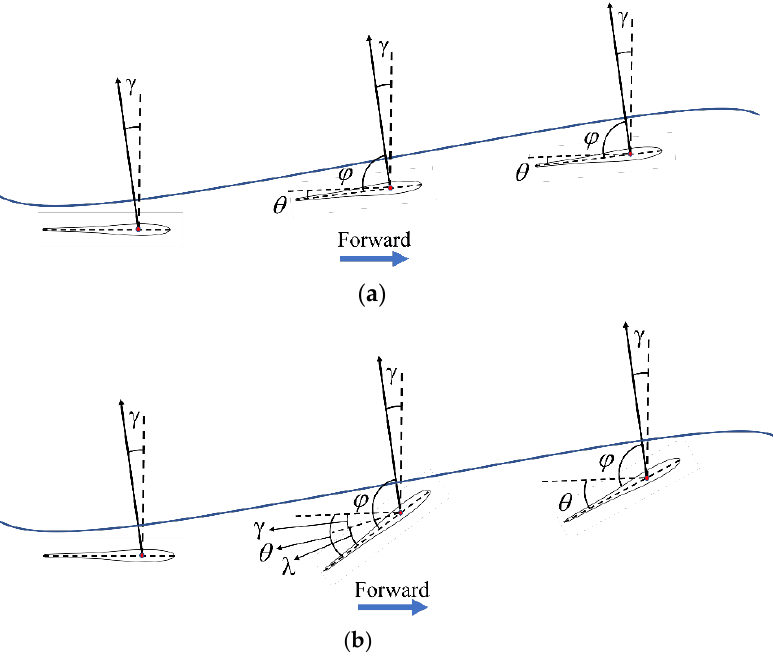
Figure 5. The wave glider moves from trough to crest with the small wave height. ( a ) Conventional submerged glider; and ( b ) self-adjusting lower-limit submerged glider.